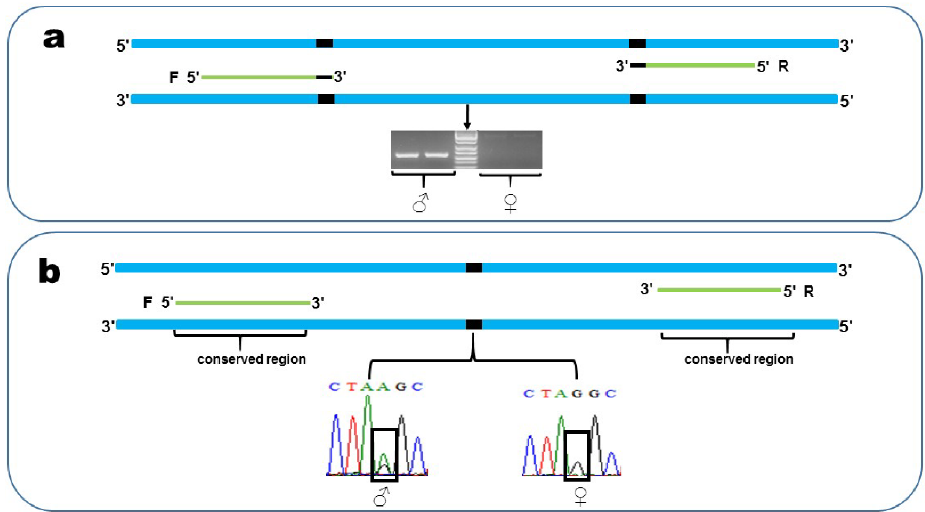
Figure 2. Primer design for sex-linked markers. Examples suggest an XX / XY sex chromosome system, but the results are similar in species with a ZZ / ZW system. All primers (green line) are designed based on the Y alleles (blue line), and ‘F’ and ‘R’ indicate forward primer and reverse primer, respectively. Black segments indicate Y-specific SNPs that do not occur on the X. Female individuals are represented by the symbol ‘ ♀ ’ and male individuals are represented by the symbol ‘ ♂ ’. ( a ) Both the forward and reverse primers were designed at Y-specific SNPs. The Y-specific base was set as the first base of the 3′ of the primer sequence. With the PCR products separated by gel electrophoresis, we expected to see a band in the male but not the female. ( b ) Both of the forward and reverse primers were designed at the conserved region. After being sequenced, we expected to see heterozygosity in the male and homozygosity in the female at SNPs (black box)